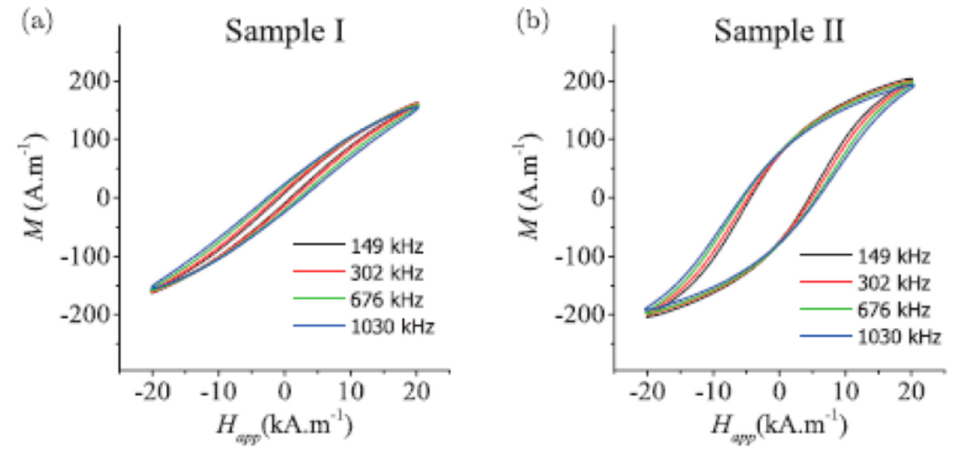
Figure 10. Dynamic hysteresis at different magnetic field frequencies for two iron oxide nanoparticle diameters: ( a ) Sample I 9 nm and ( b ) Sample II 21 nm. Reprinted with permission from Reference [134].